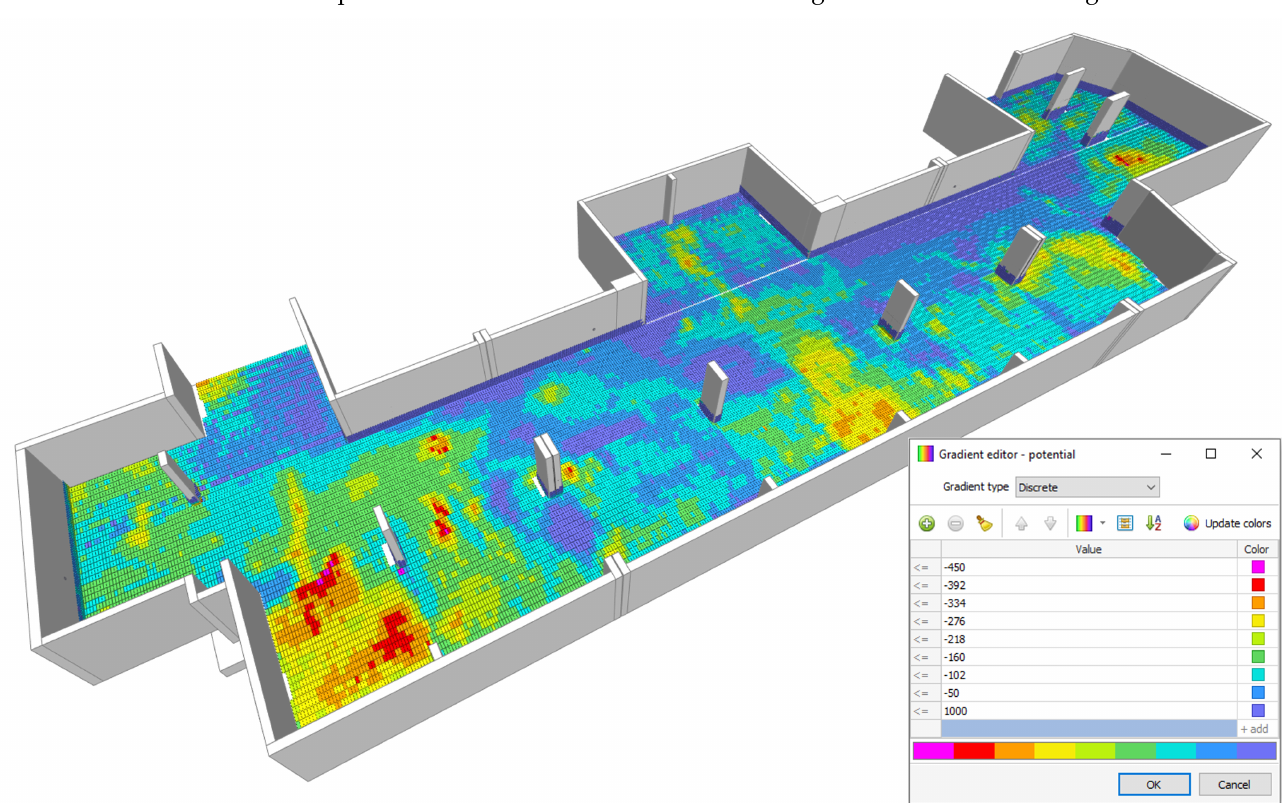
Figure 2. Implementation of the measured values of half-cell potential measurements in